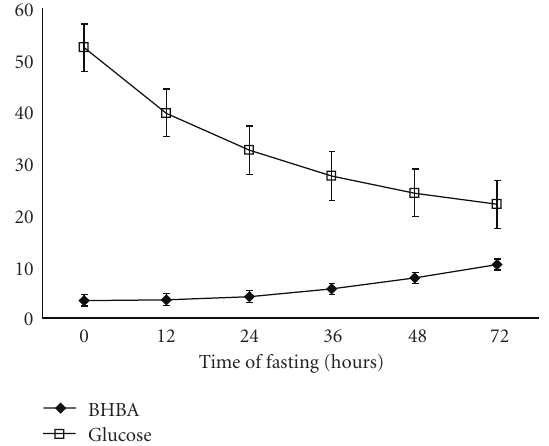
Figure 4: Concentration of β -HBA and glucose (mg/dl) in experimentally pregnancy toxemic goats. Di ff erences in the letters indicate beginning of the significant di ff erences.